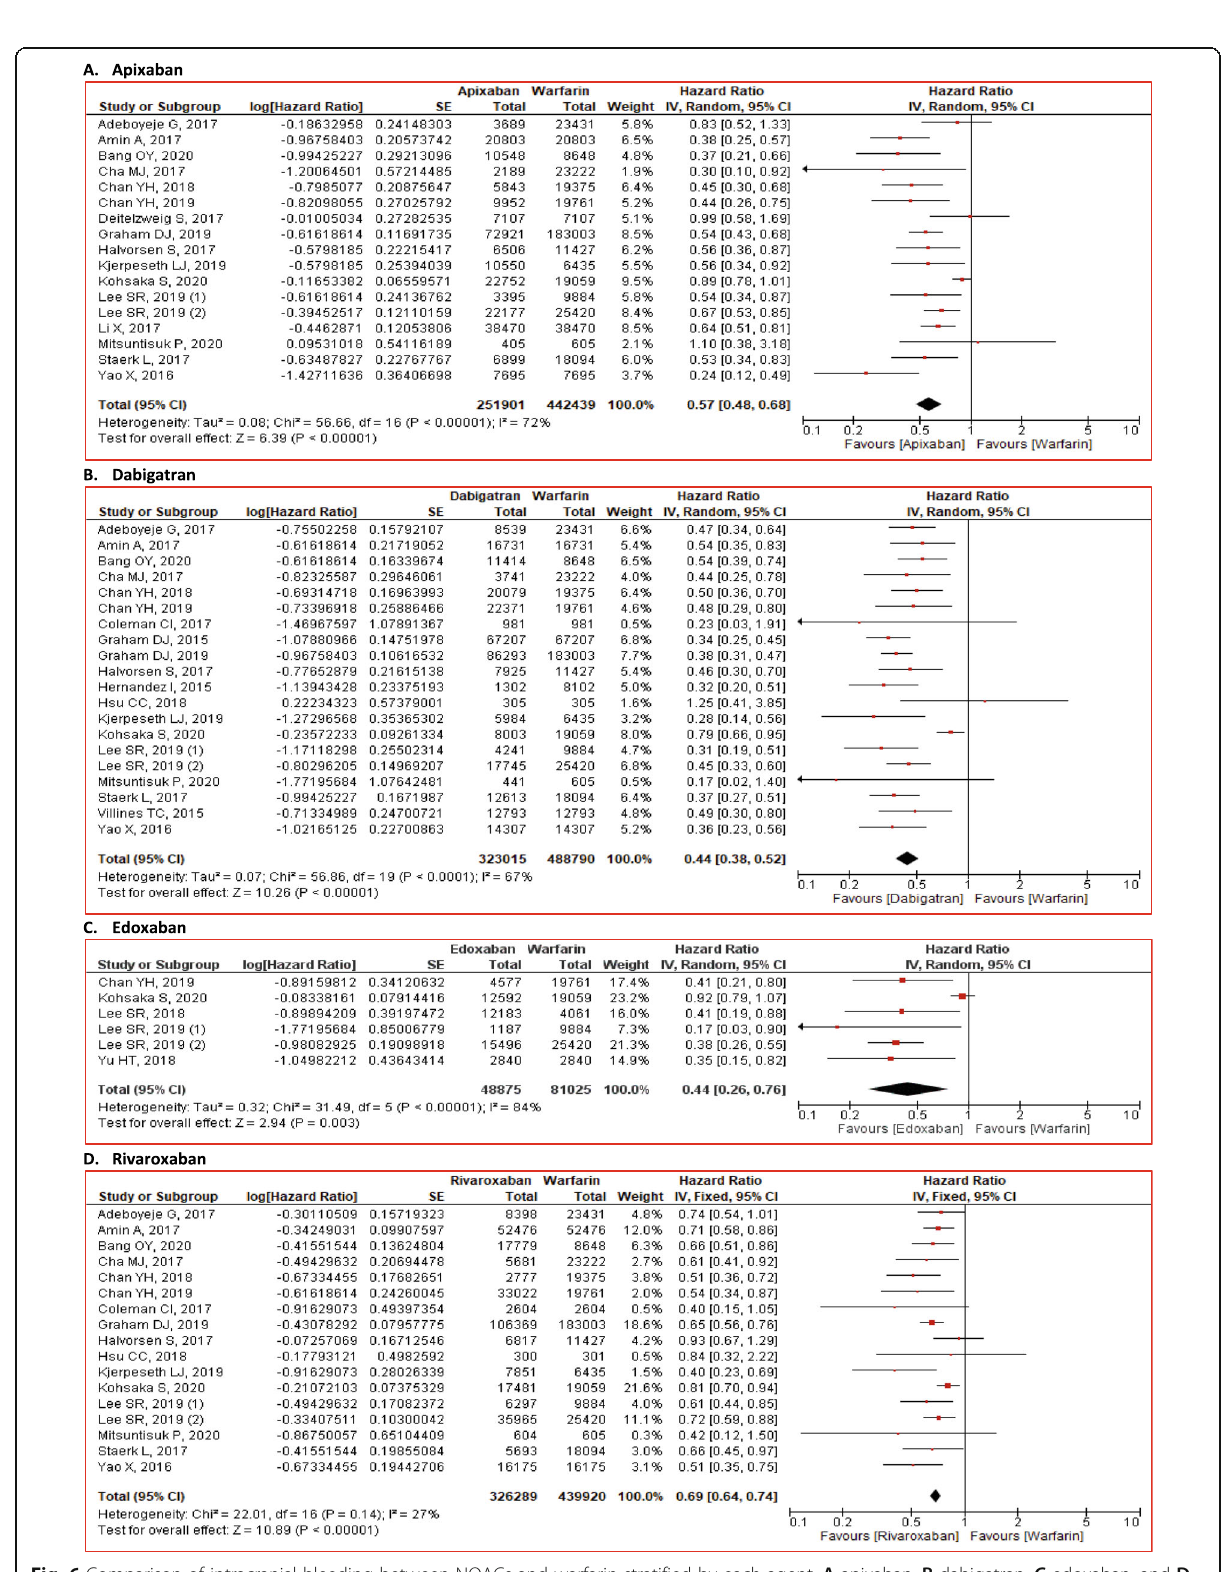
Fig. 6 Comparison of intracranial bleeding between NOACs and warfarin stratified by each agent. A apixaban, B dabigatran, C edoxaban, and D rivaroxaban. CI = confidence interval, NOACs = non-vitamin K antagonist oral